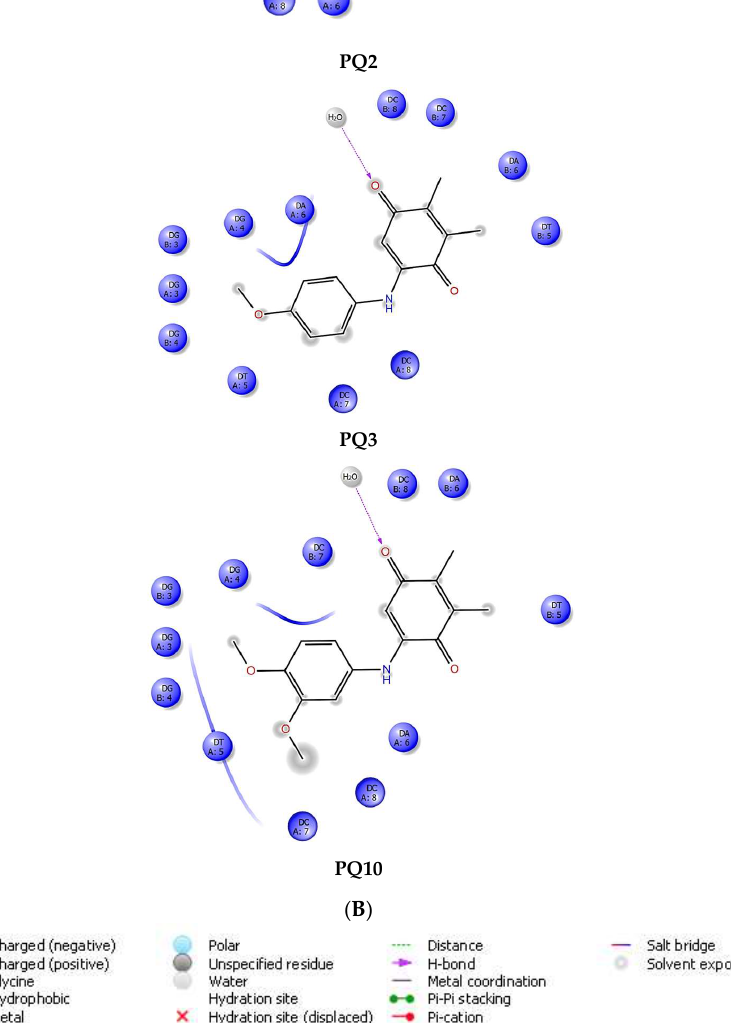
Figure 10. Docking poses ( A ) and interactions ( B ) of PQ2 , PQ3 and PQ10 (ligands are highlighted in dark green-, orange- and turquoise-colored sticks) in the minor groove of the double helix of DNA (PDB ID: 2GWA).